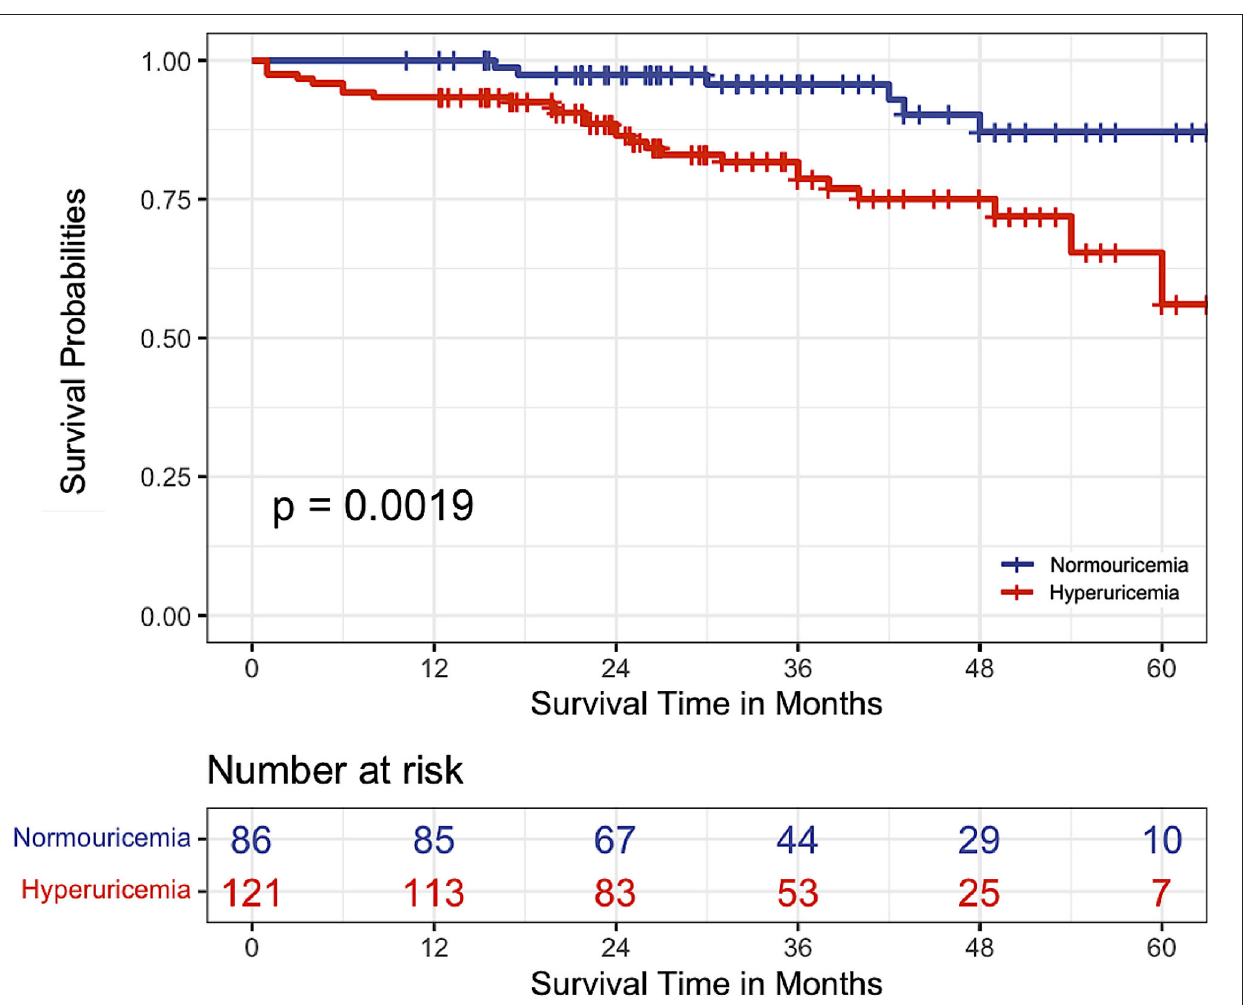
Frontiers in Medicine |